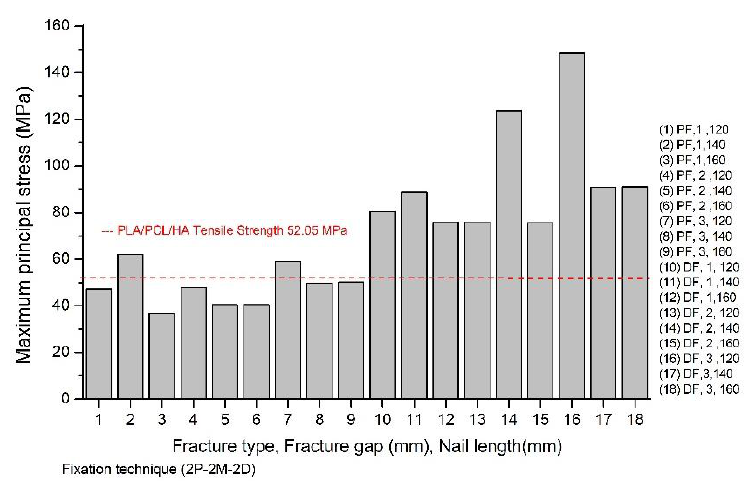
Figure 17. The maximum principal stress of the six locking screws in the biocomposite interlocking nails with different fracture types, different fracture gap, and different interlocking nail length.